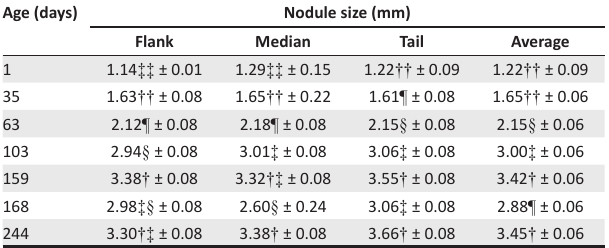
TABLE 8: Average nodule size (mm) and the standard error of the measured nodules for every slaughter